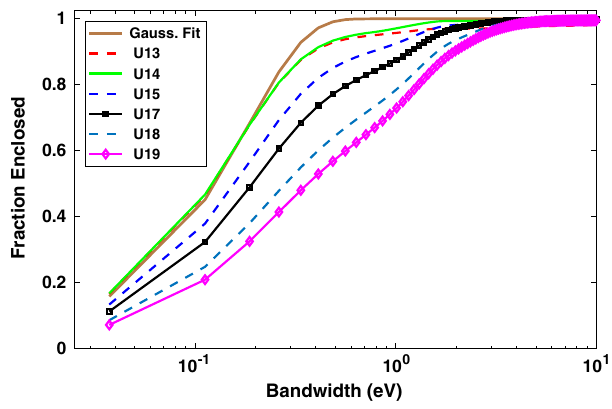
FIG. 5. Fraction of spectral energy as a function of integrated bandwidth for different effective undulator lengths for the October 2016 shift. For this data PSF-blurring has been removed via deconvolution. The curve labeled “ Gauss. Fit ” corresponds to a Gaussian with a FWHM of 220